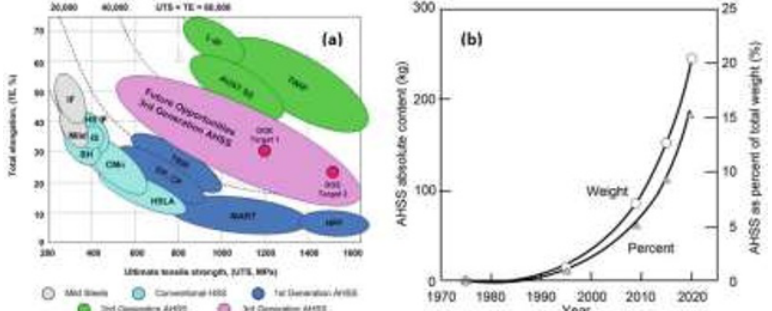
Fig. 1. Total Elongation versus Ultimate Tensile Strength classification of HSS and